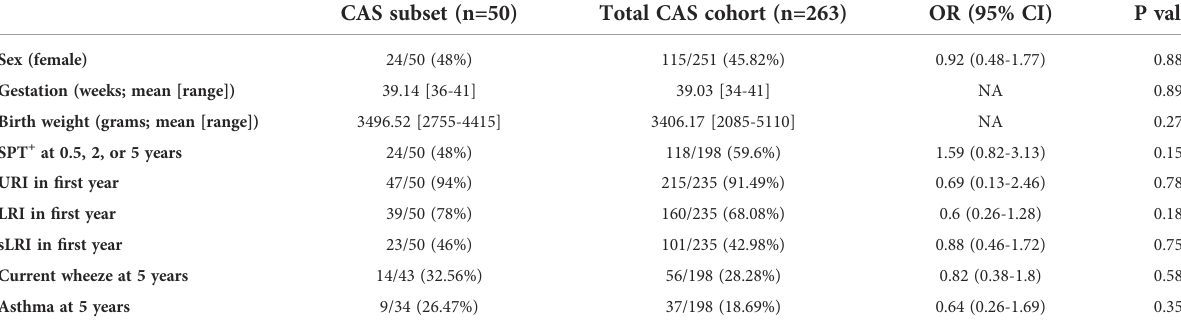
TABLE 1 Characteristics and representativeness of the study